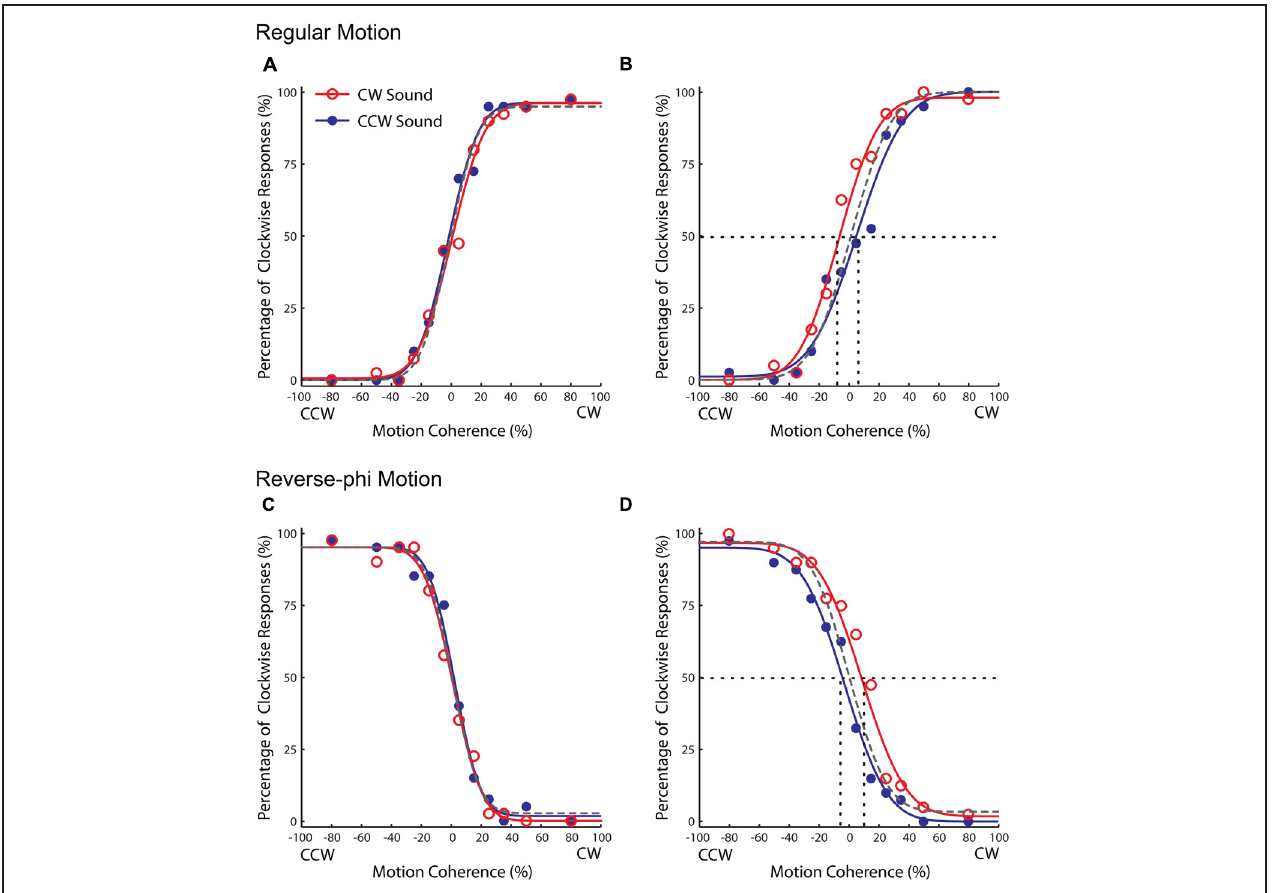
FIGURE 2 | Results of Experiment 1 (regular motion used in the association phase). Group averaged data ( n = 5, four were naïve observers) for different experimental conditions. Top panel: pre-association (A) and post-association (B) data for regular motion. Bottom panel: pre-association (C) and post-association (D) data for reverse-phi motion. Each plot indicates the proportion of trials in which the visual stimulus was judged to rotate in